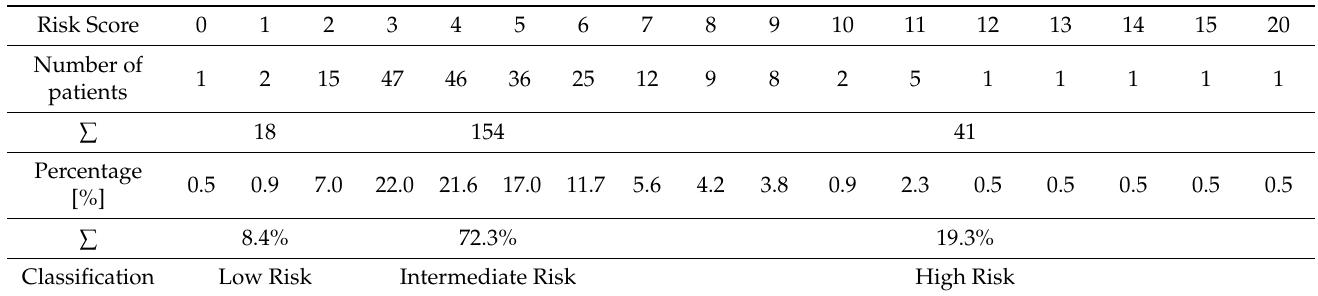
Table 1. Distribution of the risk assessment of 213 patients based on the checklist of the German Consortium for Hereditary Breast and Ovarian Cancer